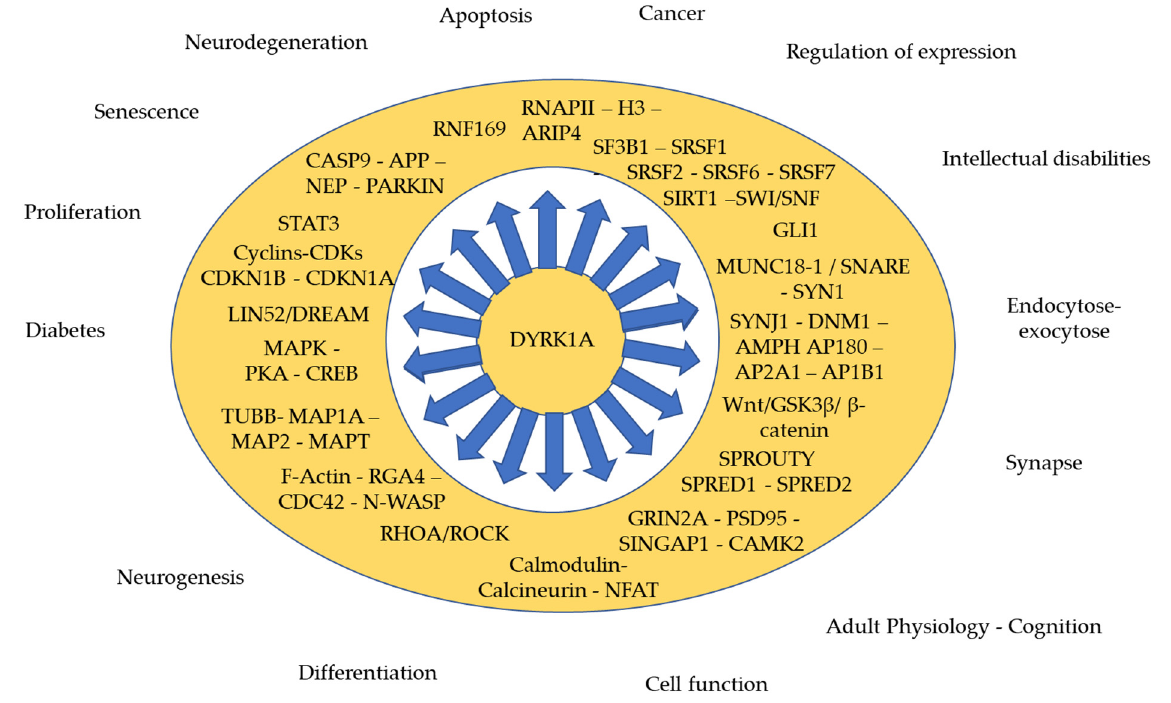
Figure 1. DYRK1A involved in various cellular processes during development and throughout the adult lifetime.